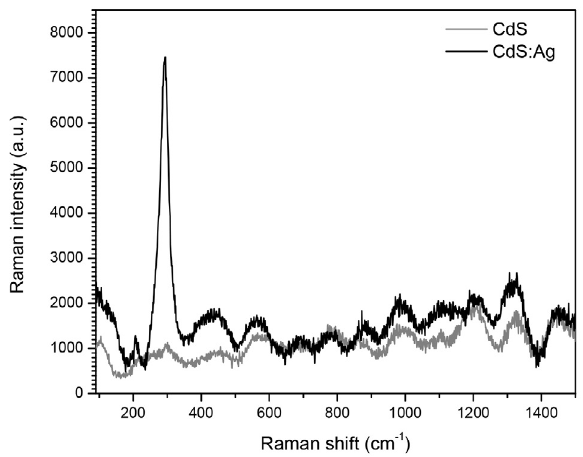
Figure 8. Raman dispersion spectra of CdS (gray solid line) and silver coated CdS (black solid line) thin films. face-enhanced Raman scattering) effect. Similar